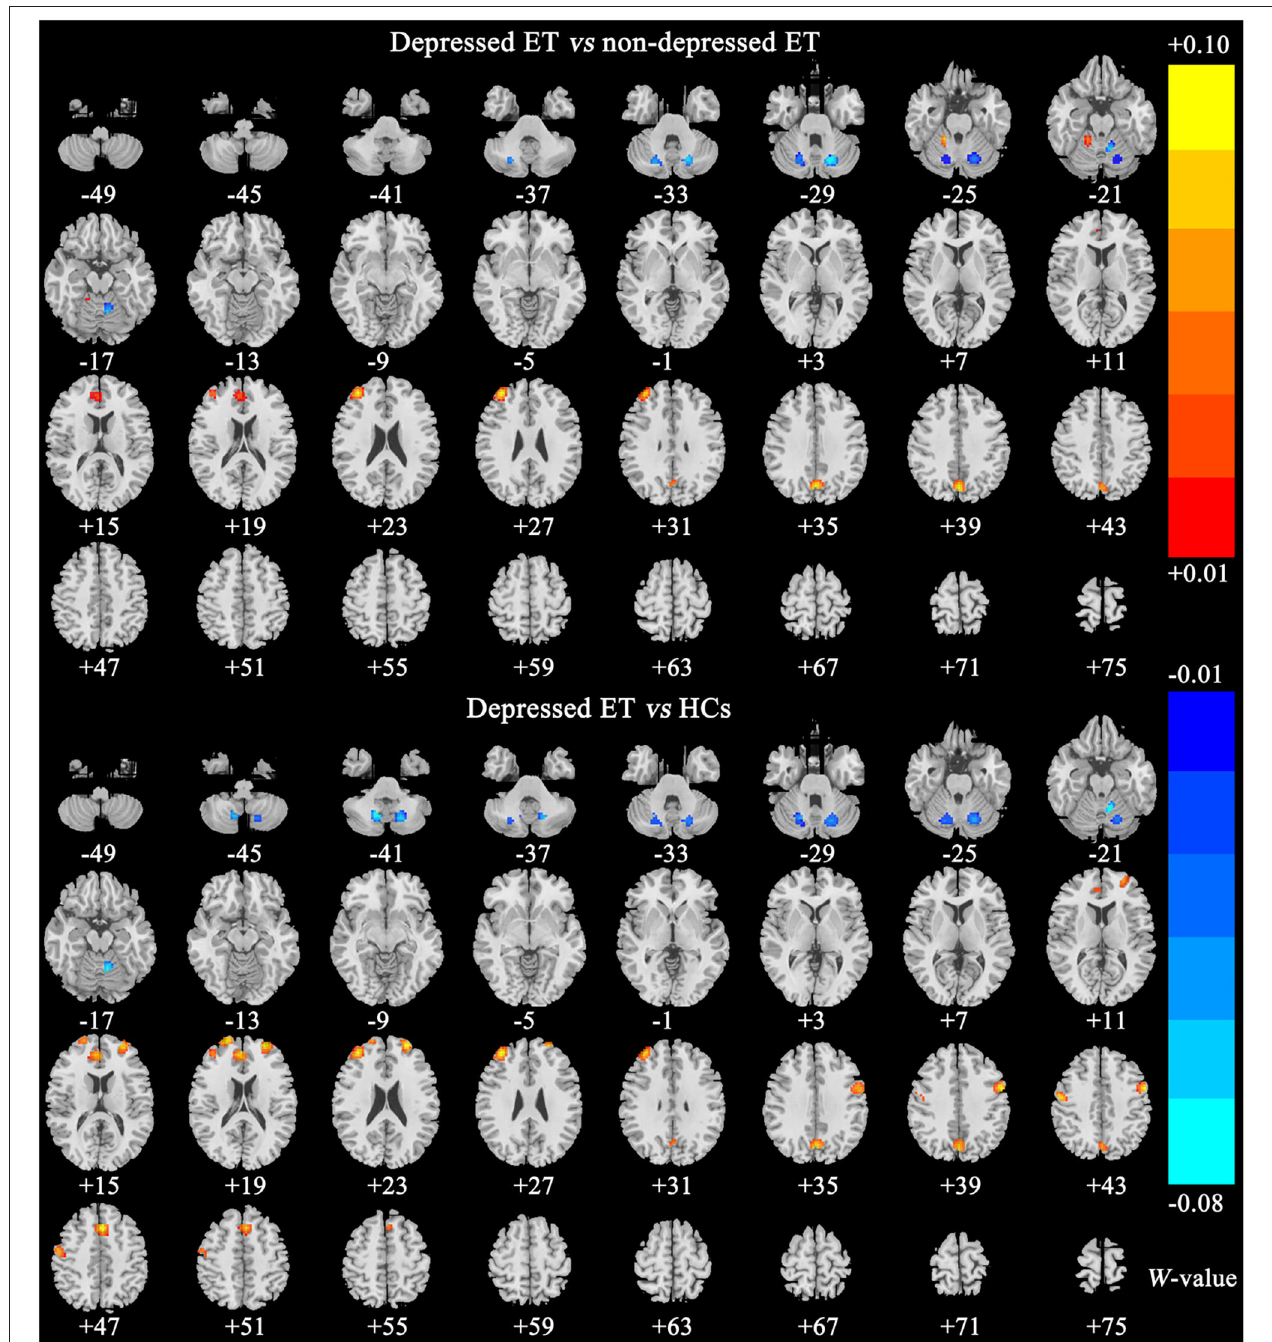
FIGURE 2 | The brain regions of significant discriminative features in classification of depressed ET vs. non-depressed ET and depressed ET vs. HCs. ET, essential tremor; HCs, healthy controls.